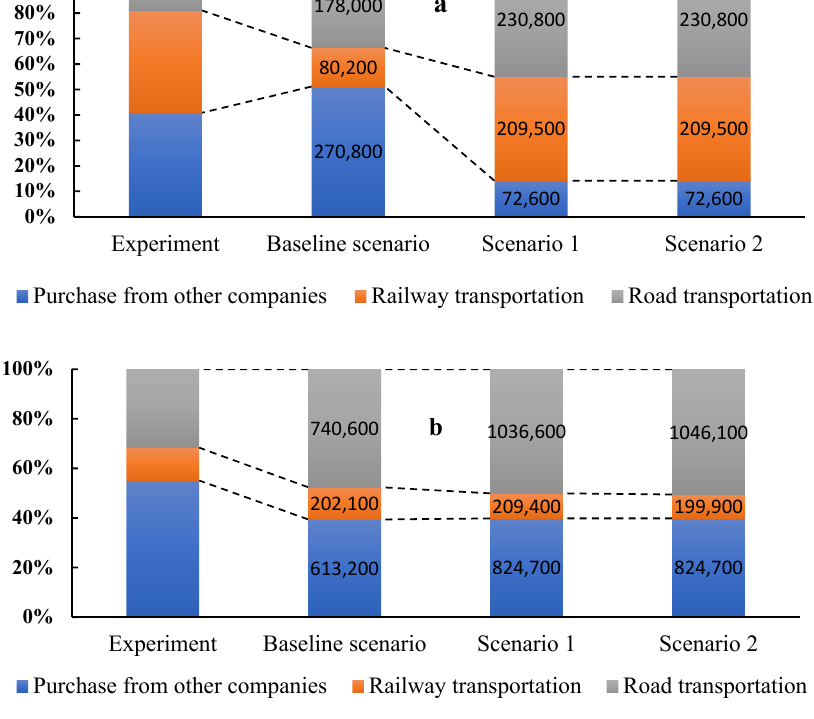
Figure 6. Pulpwood amounts (m 3 ) by origin and by transport modes in experiment and scenarios, separately, at integrates ( a ) and ( b ).